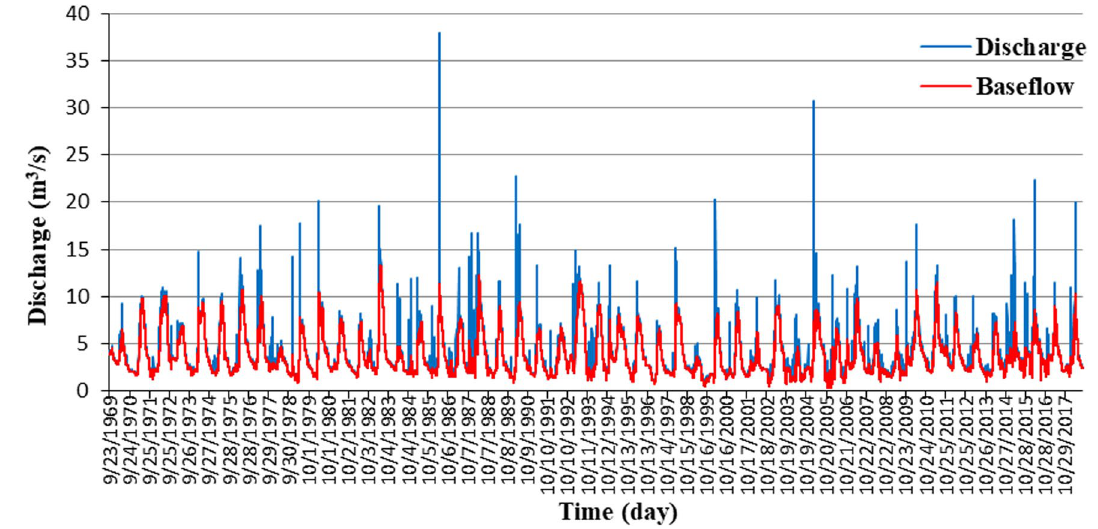
Fig. 3 Baseflow separation of Gamasiyab spring with WT-Db4 wavelet function-at level 6-period of 1969–2018